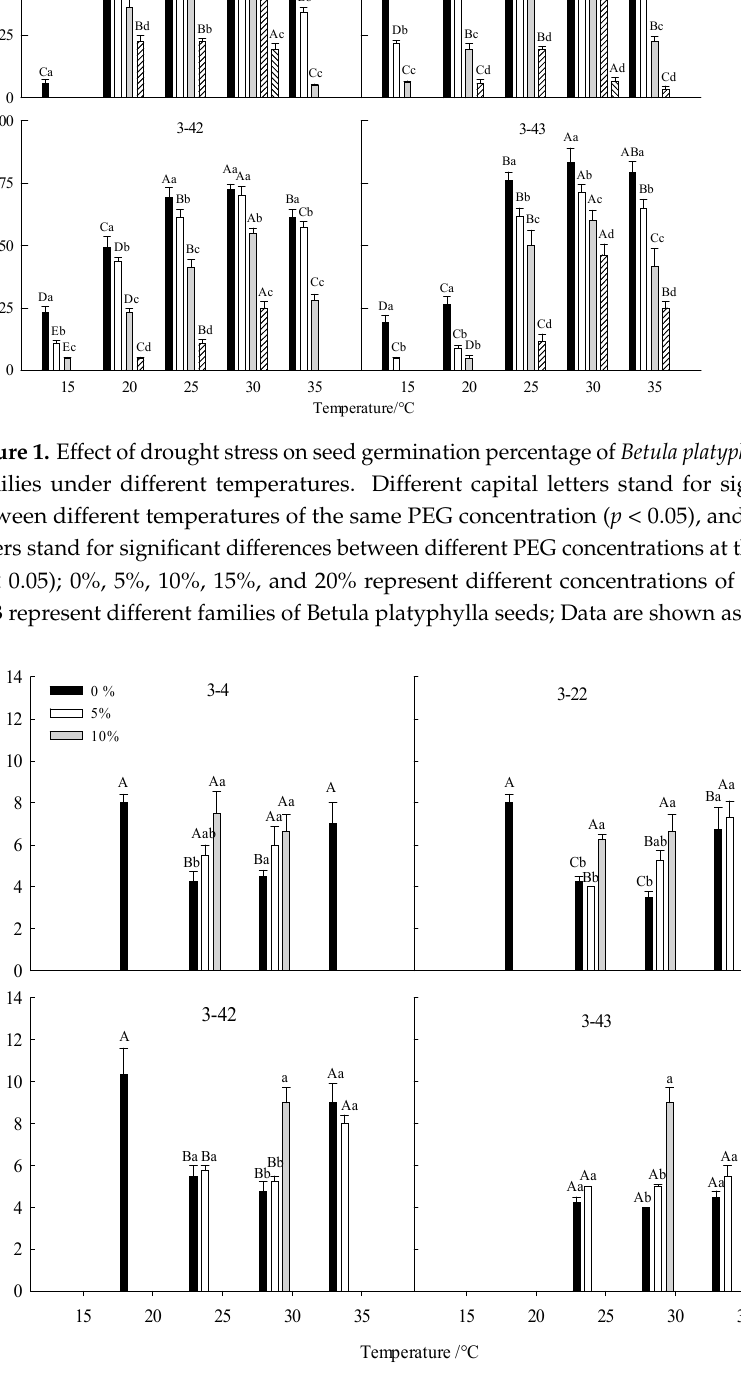
Figure 2. Effect of drought stress on the time to 50% germination of seeds of Betula platyphylla in different families under different temperatures. Different capital letters stand for significant differences between different temperatures of the same PEG concentration ( p < 0.05), and different lowercase letters stand for significant differences between different PEG concentrations at the same temperature ( p < 0.05).